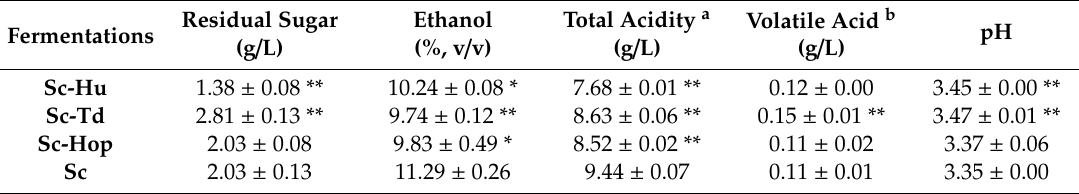
Table 1. Physicochemical parameters of citrus wines (Means ± SD).